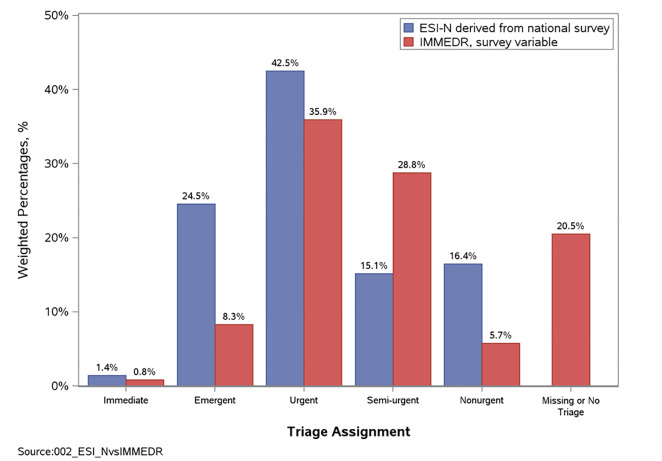
Distribution of Emergency Severity Index levels based on the presenting complaint.IMMEDR, immediacy.